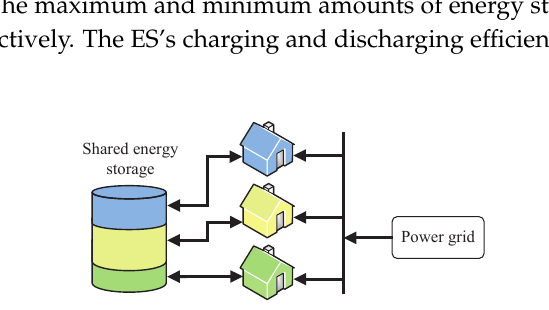
Figure 1. An energy storage device shared by multiple residential energy users.